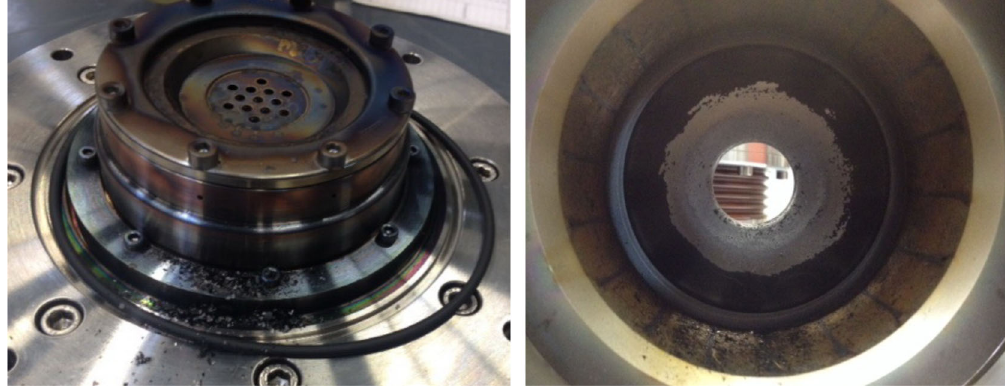
FIG. 6. Contamination of the extraction system (left) and the plasma chamber (right) of the ion source with carbon after six days of operation.